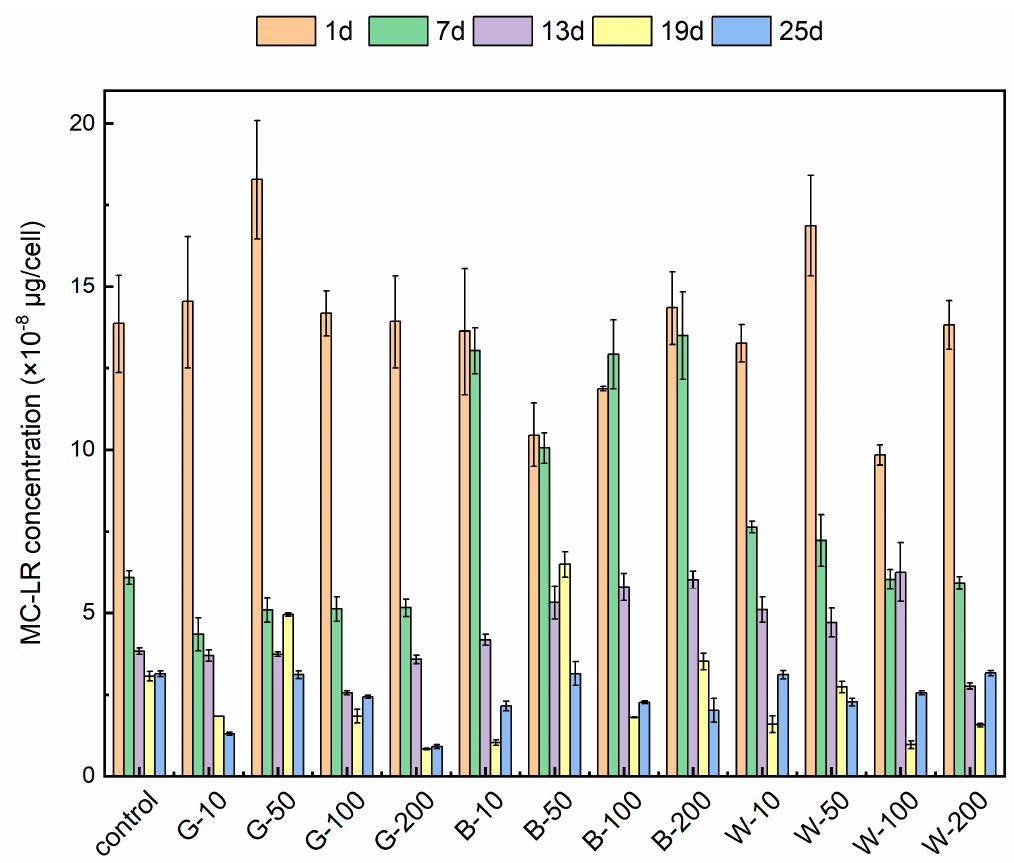
Figure 4. Effect of mPET on the MC − LR production of M. aeruginosa . G − 10 refers to green − 10 mg/L mPET, B − 10 refers to black − 10 mg/L mPET, W − 10 refers to white − 10 mg/L mPET and the rest may be deduced by analogy.